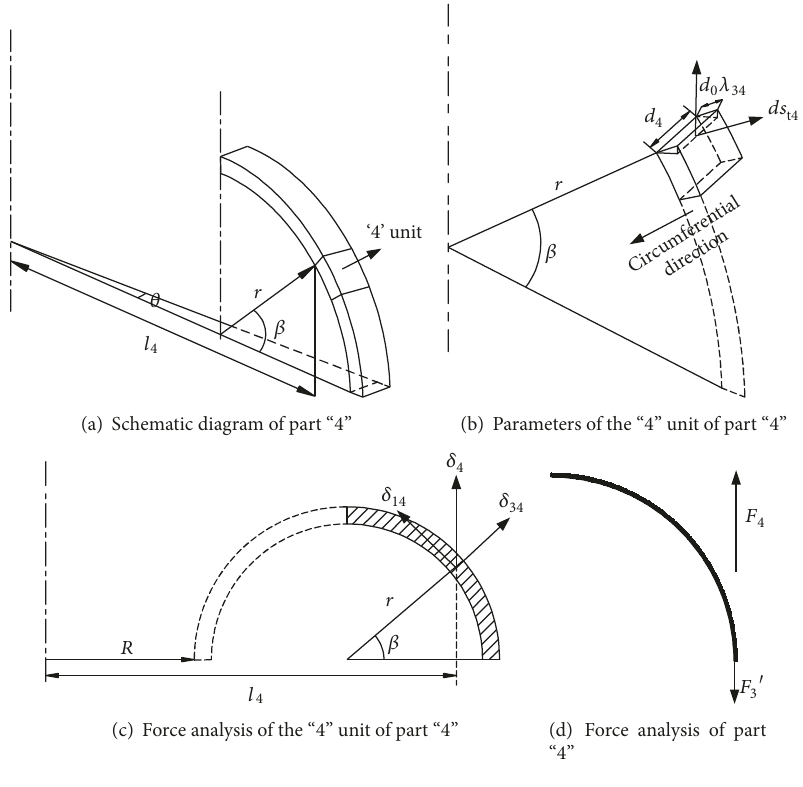
Figure 10: Force analysis of part “4” of the elastomeric